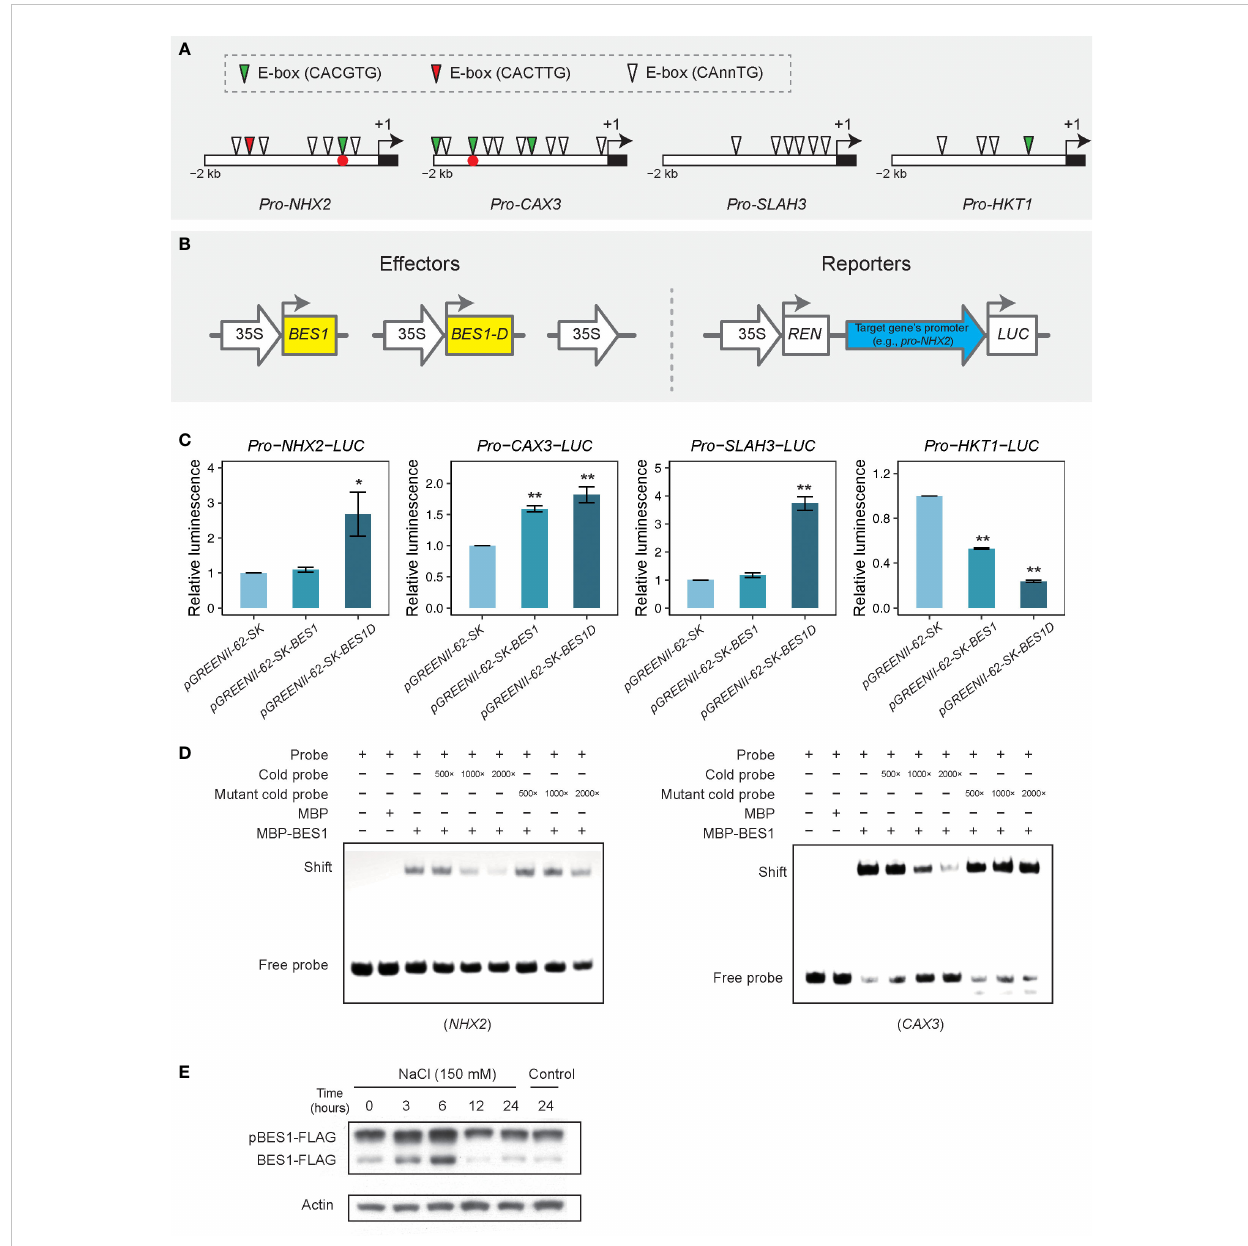
FIGURE 8 Transient expression assay for transcriptional activation or repression activity of BES1 on target genes by using luciferase luminescence and EMSA. (A) Motif analysis in promoters of putative target genes. Empty boxes represent upstream 2-kb of open reading frame (ORF) region. Black block means start codon and arrows are translational direction. (B) Transient expression assay and construct structures. Thick arrows denote promoters while rectangles are coding sequence (CDS) regions. Upstream 2-kb fragments of target genes were inserted to constructs for driving LUC expression. BES1-D (or BES1D) means it was cloned from the bes1-D mutant. (C) Transient assay for target genes regulated by BES1 or BES1-D. Values are means ( ± SE) of at least three replicates. Asterisks are signi fi cant differences between BES1/BES1-D and a positive control pGREENII- 35S pro -LUC ( t test, * P < 0.05, ** P < 0.01). (D) EMSA analysis of BES1 binding to the promoter regions of NHX2 and CAX3 genes. Cold probes (without biotin labeling) or mutated cold probes were used to compete with the labelled probes for binding with BES1. Positions of these two binding motifs were labeled as red dots in panel (A) . (E) Western blot analysis of BES1-FLAG protein level under salt treatment (150 mM of NaCl) at different time points. A BES1-FLAG overexpressing line was used for the salt treatment. pBES1-FLAG and BES1-FLAG denote the phosphorylated and dephosphorylated forms of BES1, respectively. Actin was used as a loading